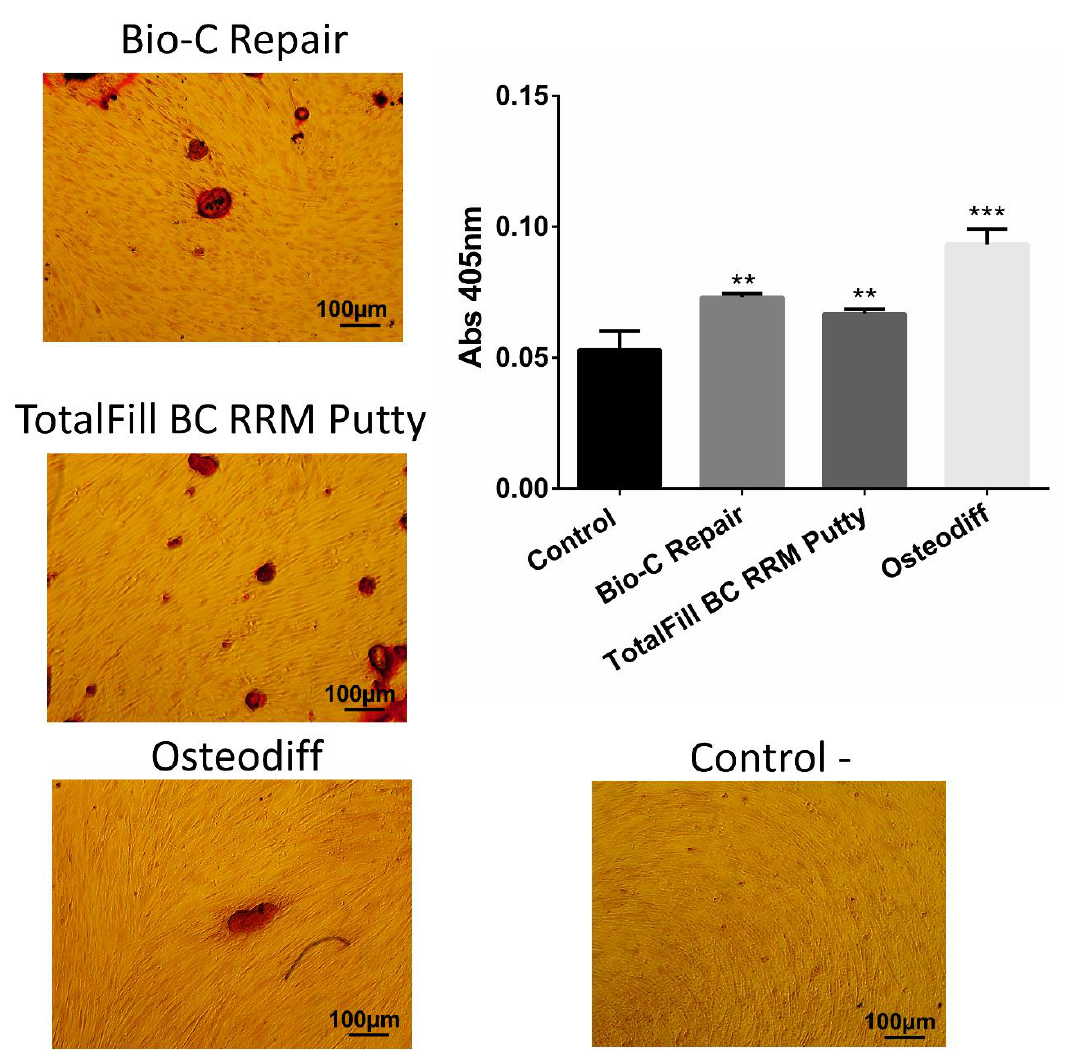
Figure 7. Mineralization capacity of root repair cements. Alizarin Red staining to evaluate the bioactivity potential of BCR and TFB. Differences observed are shown as ** p < 0.01 and *** p < 0.001.